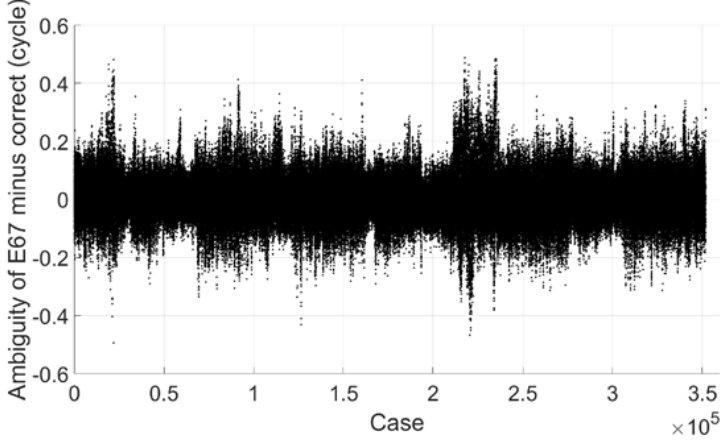
Figure 9. Extra wide-lane E67 ambiguity minus correct integer ambiguity (Galileo).